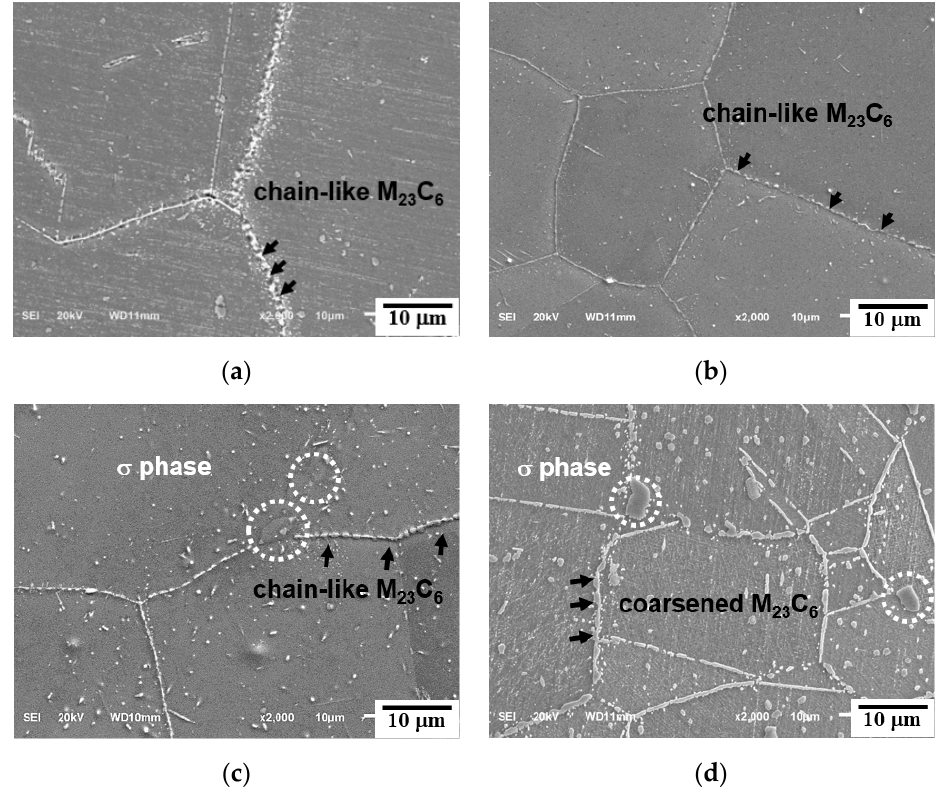
Figure 6. SEM micrographs from cross-sectional fractures of creep specimens: ( a ) 700 ◦ C/180 MPa/398 h, ( b ) 700 ◦ C/150 MPa/1463 h, ( c ) 700 ◦ C/120 MPa/3945 h, and ( d ) 700 ◦ C/90 MPa/9411 h.